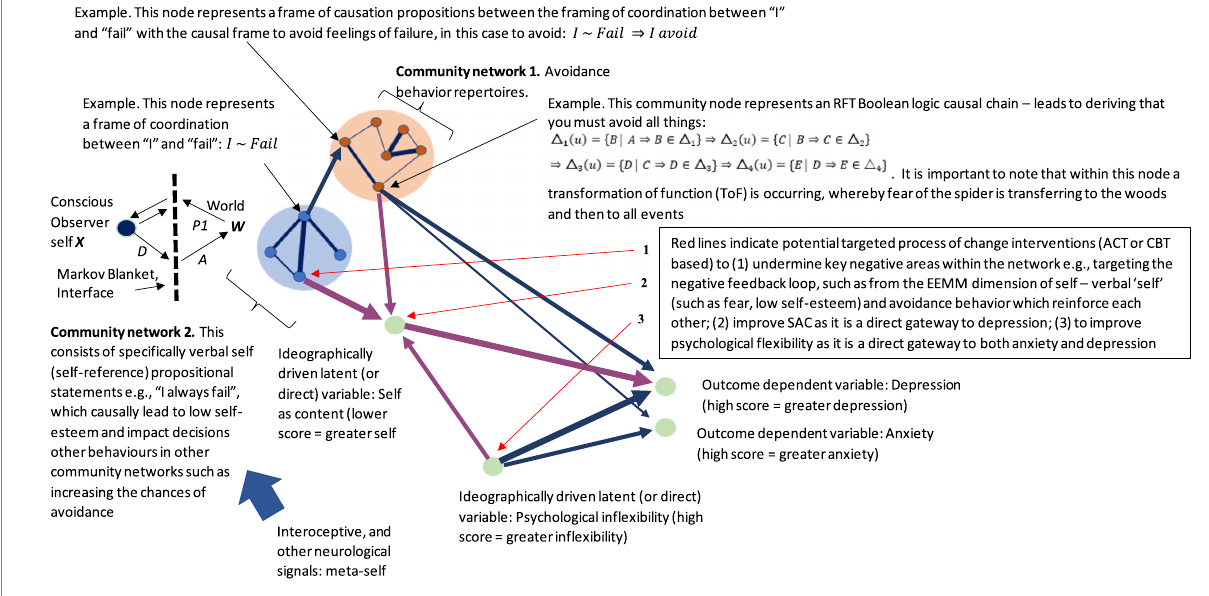
FIGURE 14 Illustration of RFT-derived Boolean logic causal chains applied to an SEM within a graph of nodes and edges G = (V, E) . Each node within a community represents a propositional causal chain (causality) or other forms of relational framing. Wider-directed lines indicate larger coefficients. Dark blue lines indicate a positive coefficient, whereas purple lines indicate negative coefficients. Note: It is plausible to assume these dynamics occur in the frontal cortex (whereby signals are fed from lower-level brain structures and body) as part of hierarchical pattern RFT relational framing